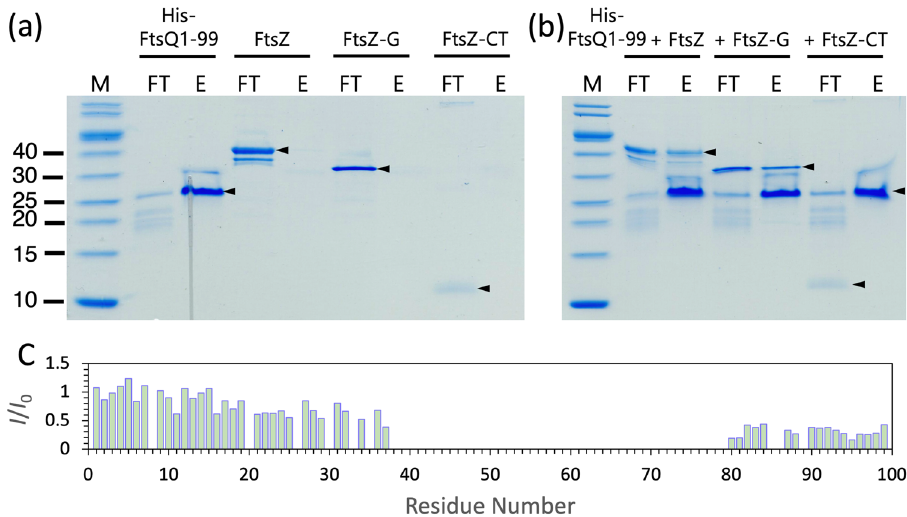
Fig. 7 Coelution and solution NMR characterization of FtsQ1-99 binding with FtsZ. a SDS-PAGE of aliquots collected from running His-tagged FtsQ1-99 (His-FtsQ1-99) and untagged full-length FtsZ or its GTPase domain (FtsZ-G) or C-tail (FtsZ-CT) individually through a nickel column. Abbreviations are: M, molecular-weight markers; FT, fl ow-through; E, elution. Arrowheads indicate the major population. b Corresponding results collected from running mixtures of His-FtsQ1-99 with FtsZ, FtsZ-G, or FtsZ-CT through a nickel column. Arrowheads indicate that FtsZ and FtsZ-G as well as His-FtsQ1-99 are found in the elution fractions but FtsZ-CT is only found in the fl ow-through fraction. c Intensity ratio of crosspeaks in the 1 H- 15 N HSQC spectra of 50 µ M uniformly 13 C – 15 N labeled FtsQ1-99 in the presence ( I ) and absence ( I 0 ) of 50 µ M FtsZ. Acquired at 800MHz and 298K in 20mM phosphate buffer (pH 6.5) with 25mM NaCl.